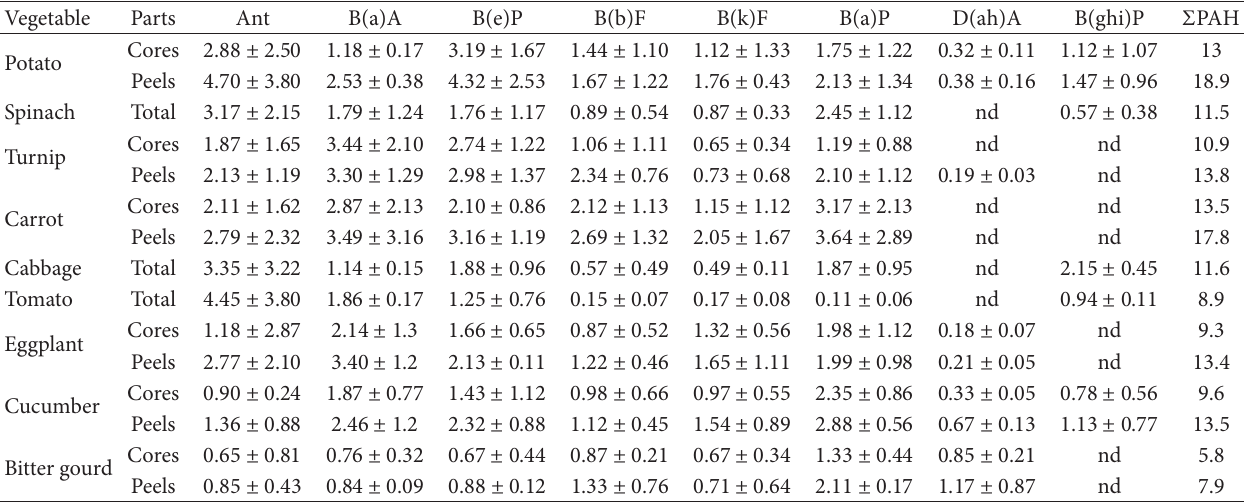
T 2: Concentrations ( g/kg; fresh weight) of various PAHs in vegetable parts. 𝜇𝜇